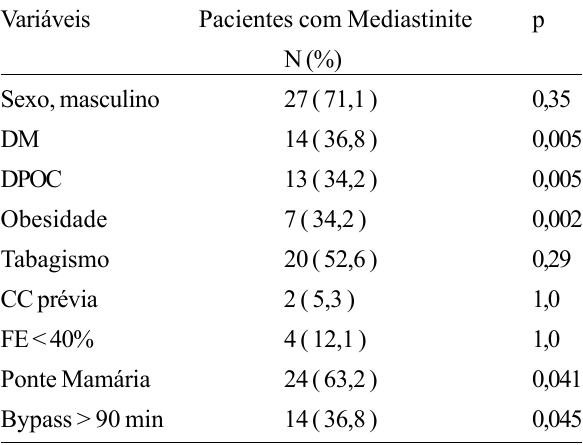
DM=diabetes mellitus;DPOC=doença pulmonar obstrutiva